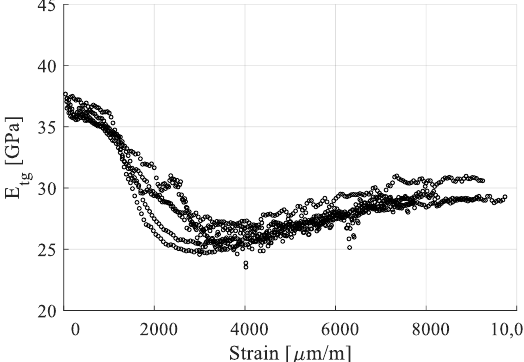
Figure 8. Tangent modulus with respect to strain.